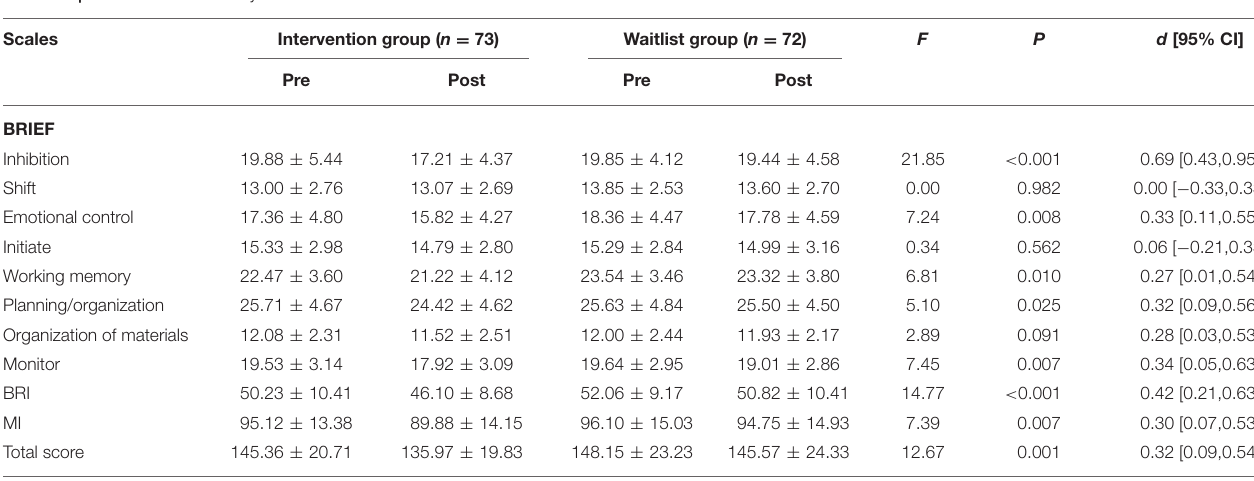
TABLE 4 | Effects of GEF-OPT by BRIEF scales.